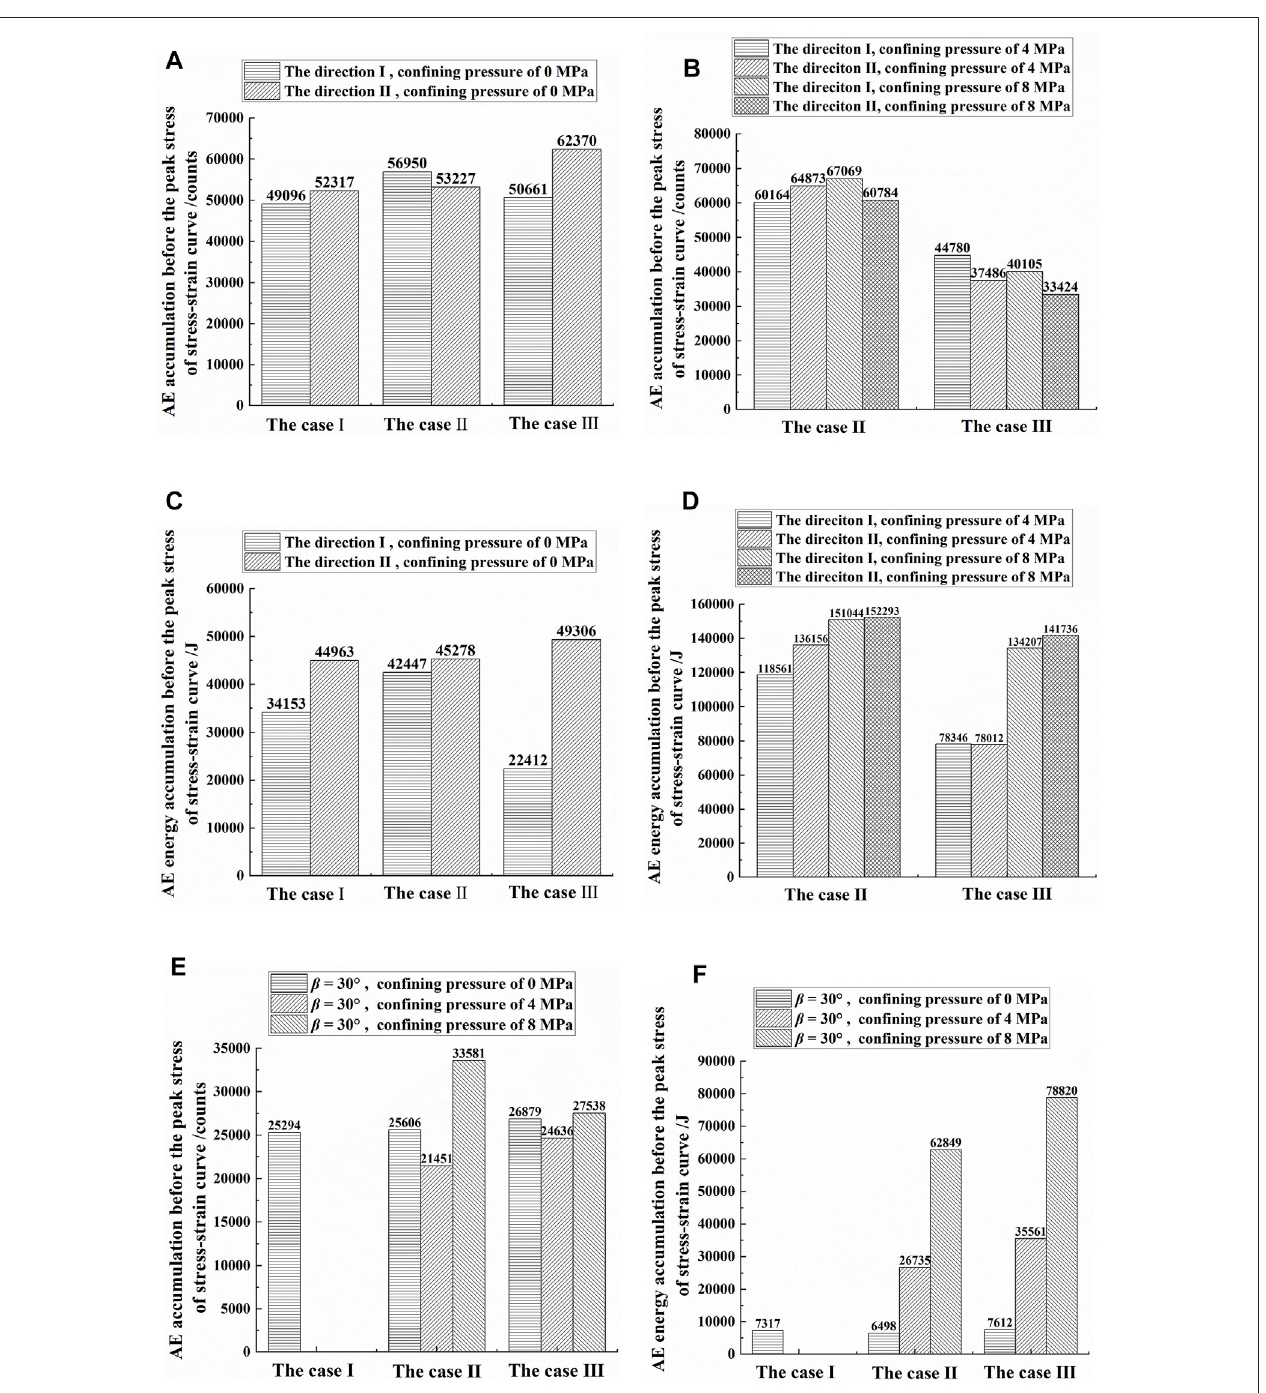
FIGURE14|(A, B) Acousticemission (AE)accumulationsbeforethe peakstressofcolumnar jointed basalts (CJBs)withdifferentmodelboundariesand con fi ning pressuresinthedirectionorthogonaltothecolumnaxis. (C,D) TheAEenergyaccumulationsbeforethepeakstressofCJBs. (E,F) TheAEaccumulationsandAEenergy accumulations before the peak stress of CJBs in the direction parallel to the column axis (case I, case II, and case III correspond to the case of plane stress, the case between plane stress and plane strain, and the case of plane strain, respectively).